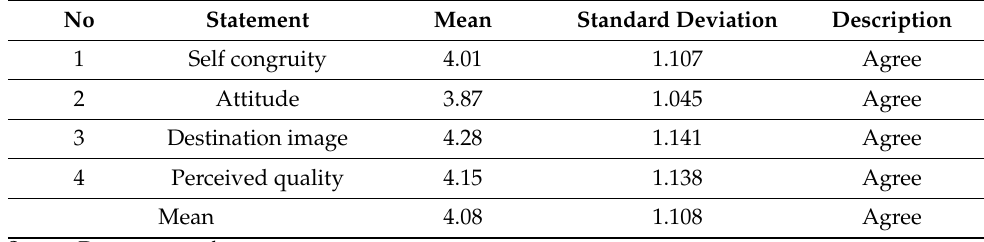
Table 4. Descriptive Statistics of Intention to Visit.